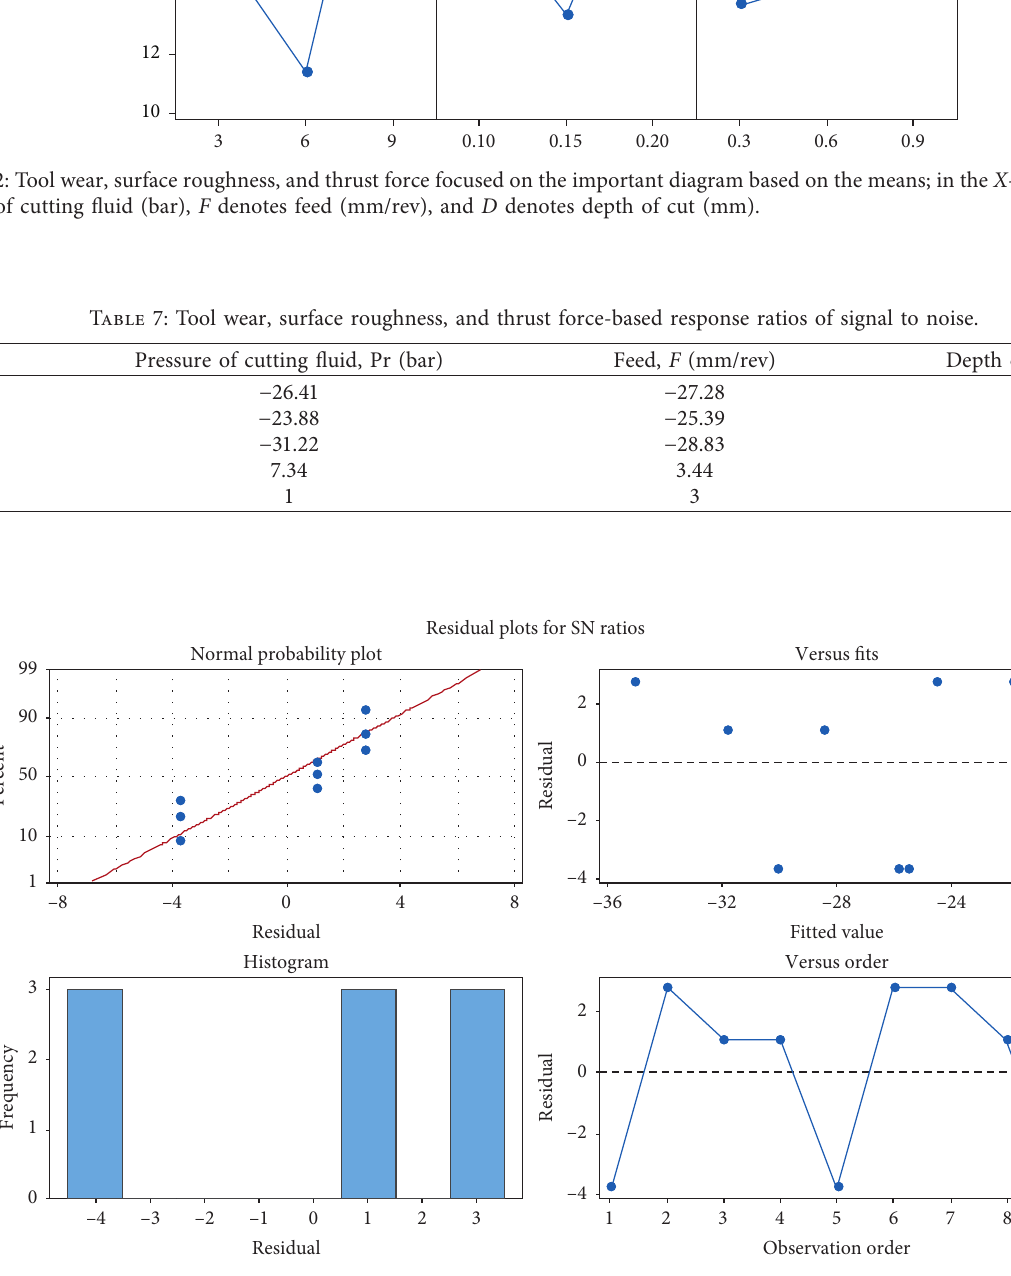
Figure 13: Tool wear, surface roughness, and thrust force-focused residual plot of percent, frequency, fitted values, and versus order.